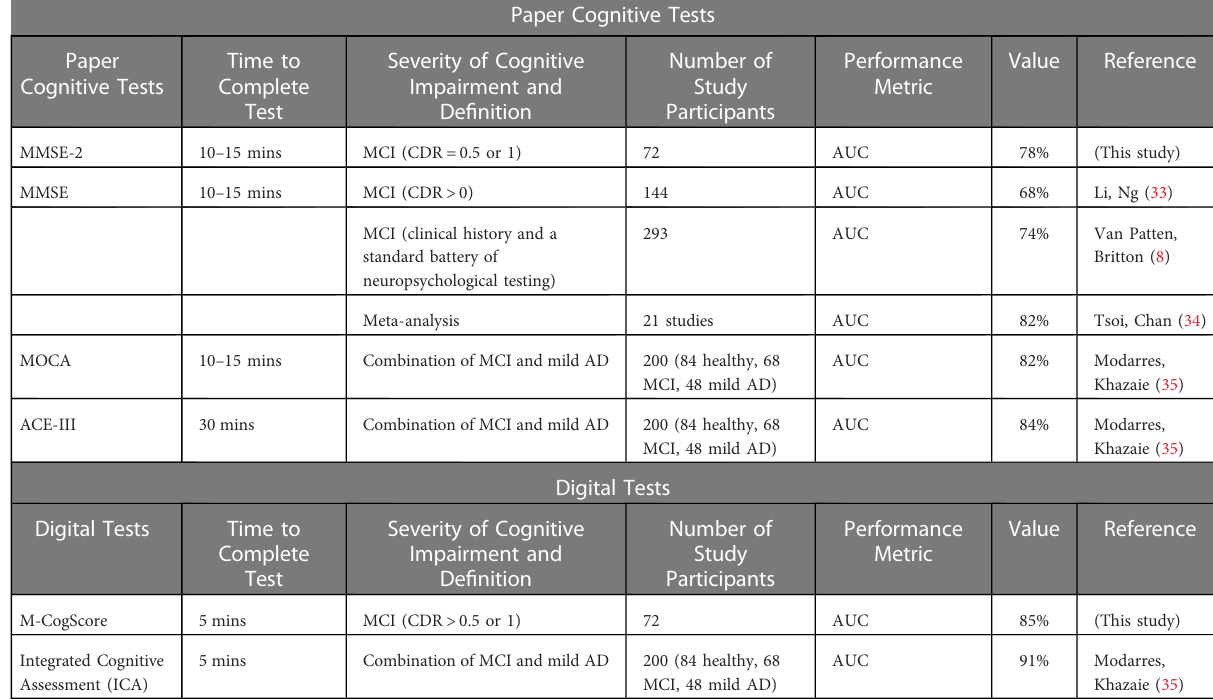
TABLE 2 Comparisons between cognitive tests in detecting MCI.